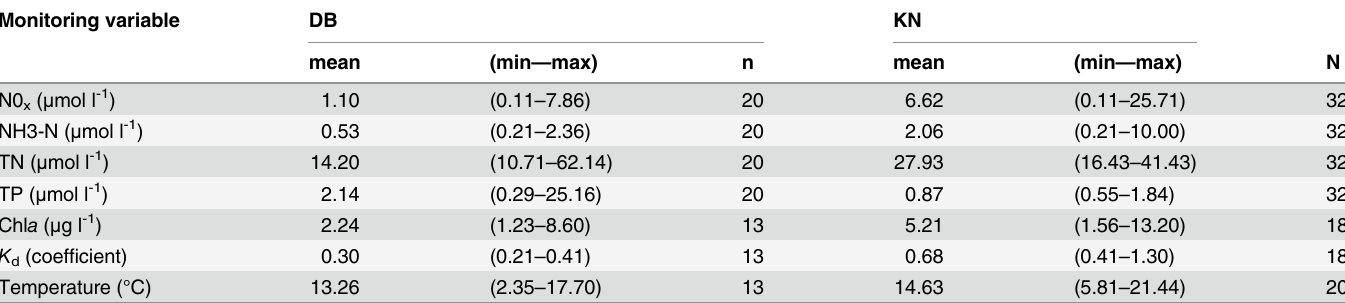
Temporal mean values calculated from sampling intervals of 1 – 3 weeks in DB and KN, 2011. Number of samplings indicated by n. Yearly means and range are given for nitrogen and phosphorous concentrations, and main growing season (April-September) means and range for chlorophyll a, the diffuse light attenuation coef fi cient ( K d ) and temperature.